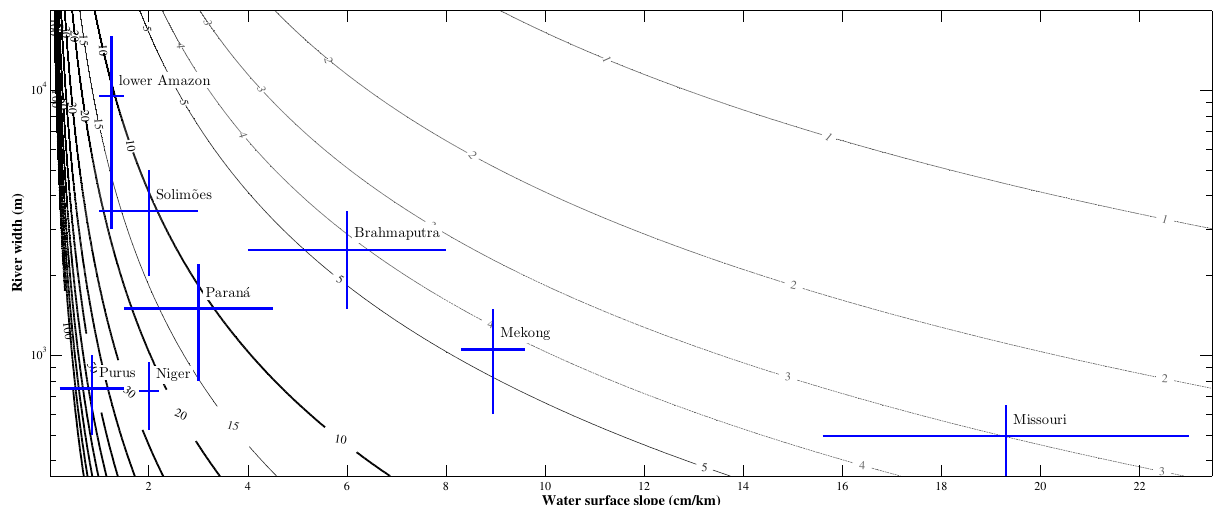
Figure 15. Examples of global rivers which may be observable by SWOT. Contours represent the percentage error in reach-averaged dis- charge ( Q ), calculated according to Eq. (6), contributed by errors in water-surface slope derived from SWOT observations, when using 5km reach lengths and cross-channel averaging. Errors may be reduced by using longer reach lengths; note that other sources of error are excluded but may be significant: without full assessment of each river, figures should be used with caution. Sources used to obtain values of river width and water-surface slopes were the Solimões and Purus rivers (Brazil) from this paper; lower Amazon River (Brazil) from Meade et al. (1985); Brahmaptura River (India) from Jung et al. (2010); Mekong River (Thailand/ Laos) from Birkinshaw et al. (2012); Missouri River (USA) from Bjerklie et al. (2005); Niger River (Mali) from Neal et al. (2012); and Paraná River (Argentina) from Depetris and Gaiero